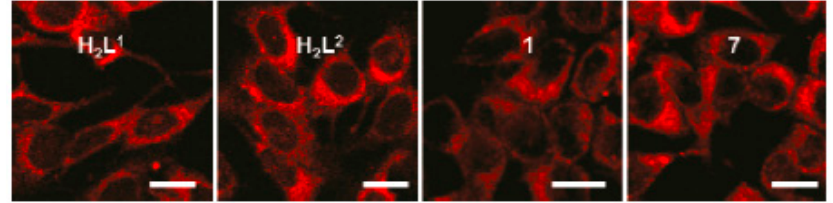
Figure 25. Fluorescent imaging of two-photon microscopy of MCF-7 cells, λ ex = 720 nm, from left to right: H 2 L 1 , H 2 L 2 , 87 , and 93 (all the scale bars represent 10 μ m).